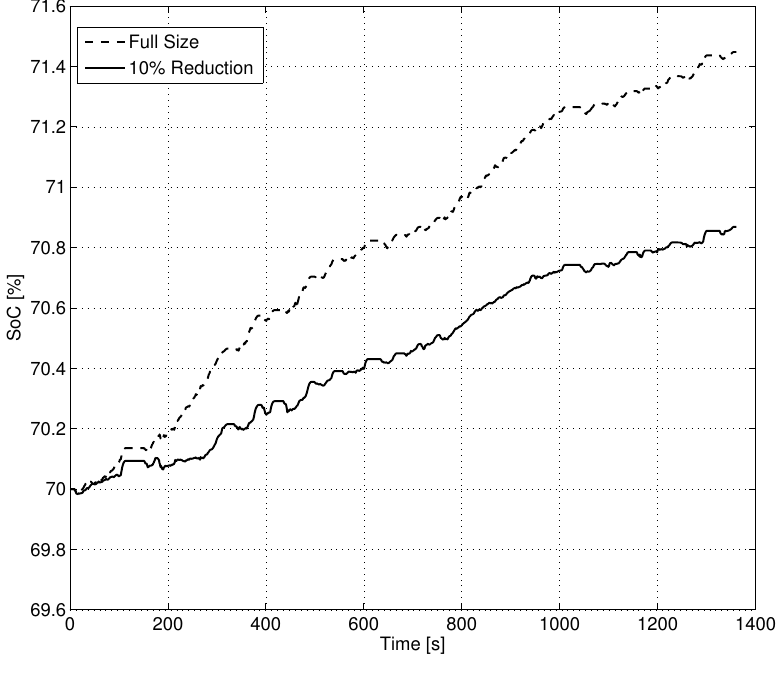
Figure 10. State of charge comparison for the